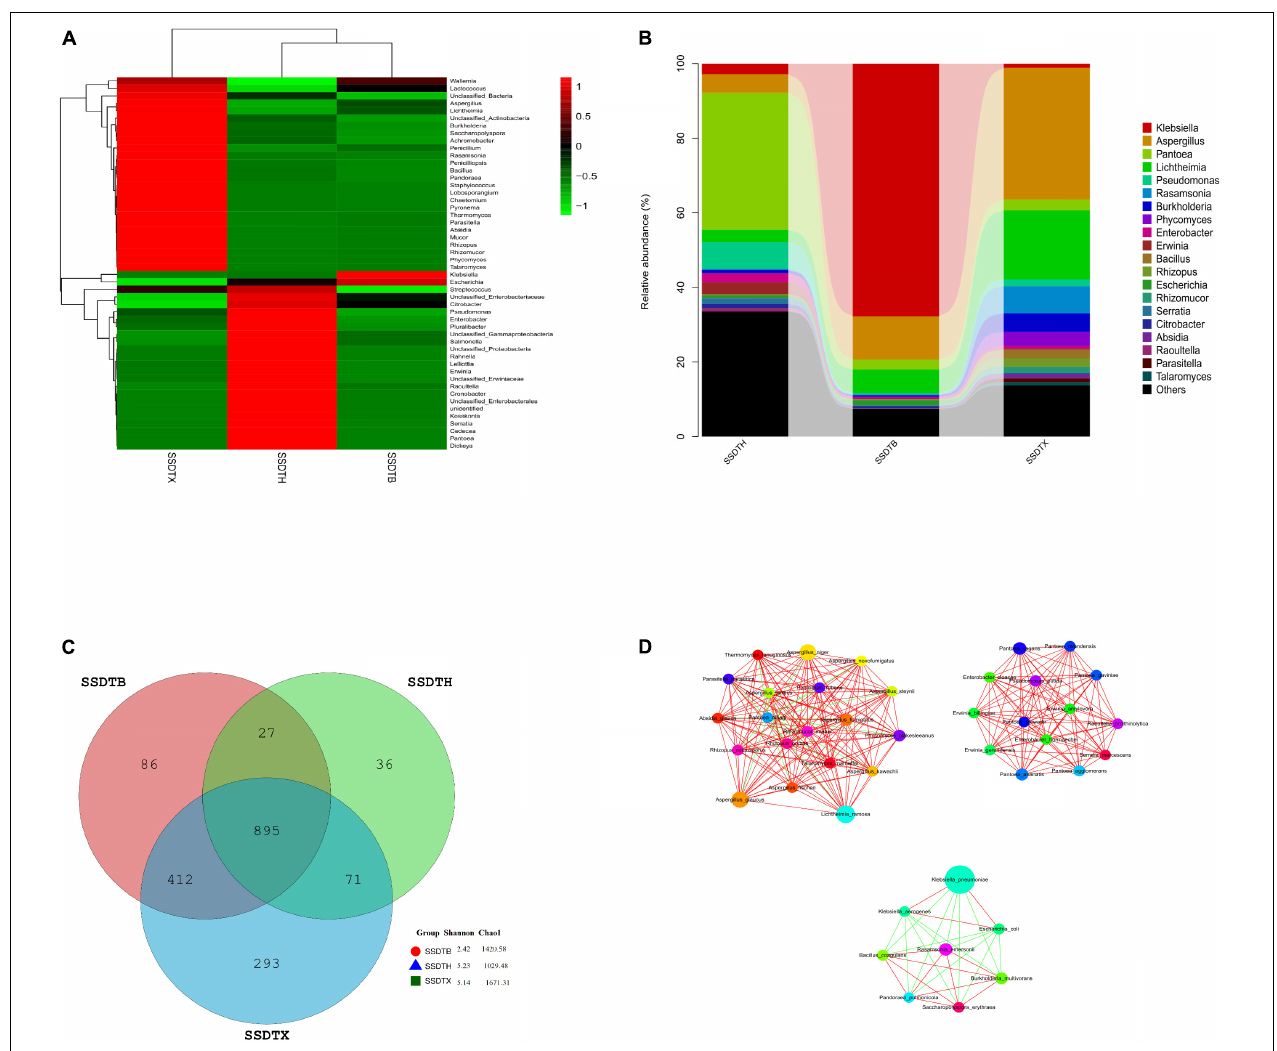
FIGURE 1 | Microbial profile of piled Sichuan South-road Dark Tea (SSDT) center at pile-fermentation metaphase. (A) Cluster analysis heatmap based on the abundance of the top 50 genera; abundance changes of different genera in each sample are displayed by color gradient of the color block, and the scale bar shows the variation range of the normalized abundance of the genera. (B) Histogram of the relative abundance of the top 20 genera; various colors represent different genera, and the relative abundance of each genus is represented by the length of the column. (C) Venn diagram; various colors represent the different samples, and numbers represent the detected species in the SSDT samples. (D) Correlation network of the top 50 dominant species; colorful nodes represent the different species, node size is proportional to their abundance, while the red solid line and the green solid line indicate the positive association and negative association between species,